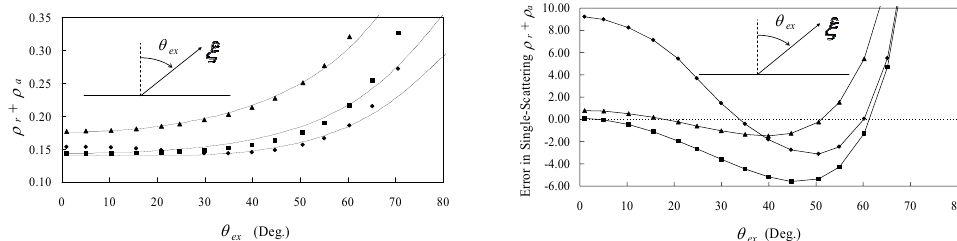
Figure 2. ( Left Panel ) Reflectance for an atmosphere with both Rayleigh and aerosol scattering slab at 412 nm, with an aerosol optical depth of 0.2, in the perpendicular plane ( φ − φ 0 = 90deg) computed using Equation (4) (symbols) and full scalar radiative transfer theory (lines). The angle the radiance exits the top of the atmosphere is θ ex , where θ ex = π − θ = cos − 1 ( | u | ) . The solar zenith angles are θ 0 = 20deg (filed circles), 40deg (filled squares), and 60deg (filled triangles). ( Right Panel ) Error (%) in reflectance computed using Equation (4). Positive error indicates that the single-scattering reflectance is too high. (Taken from